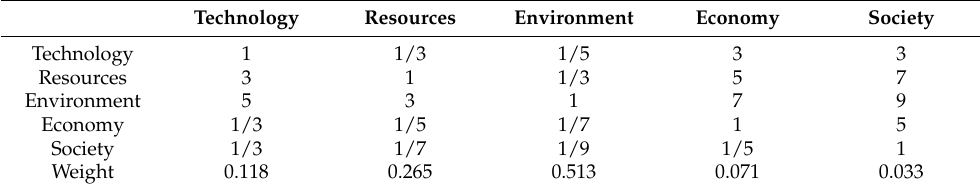
Table 3. Importance scale of different dimensional layers.